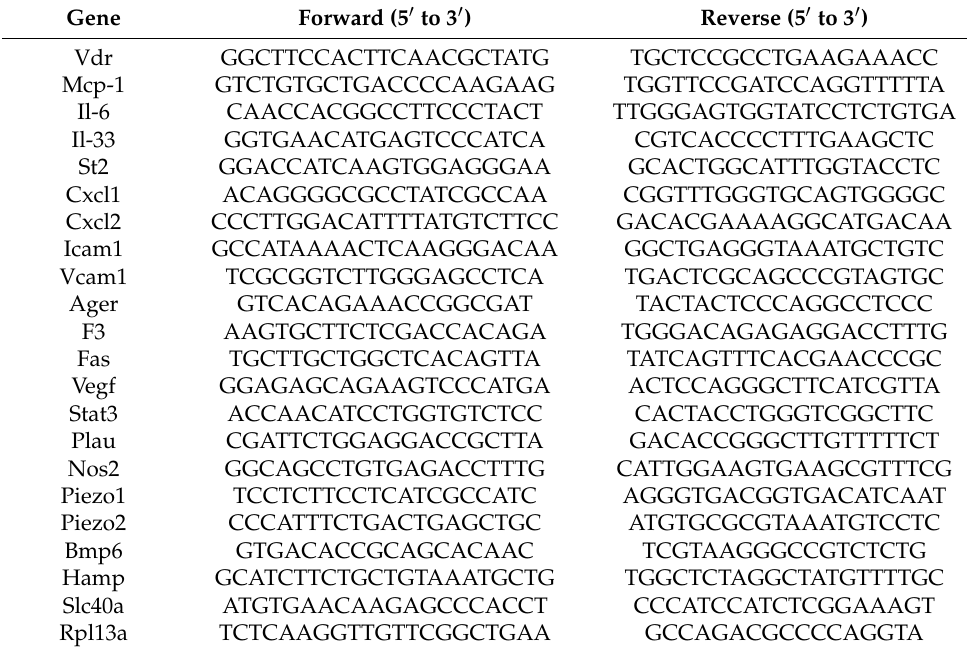
Table 1. The mouse primers used in qPCR